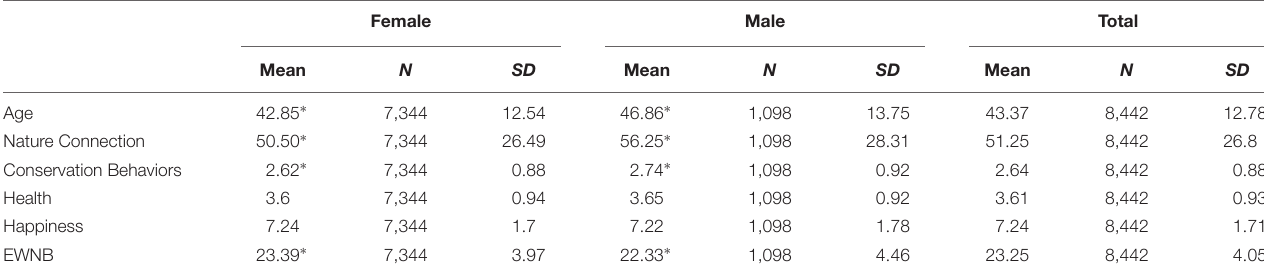
TABLE 1 | Mean and standard deviations for baseline measures by gender.